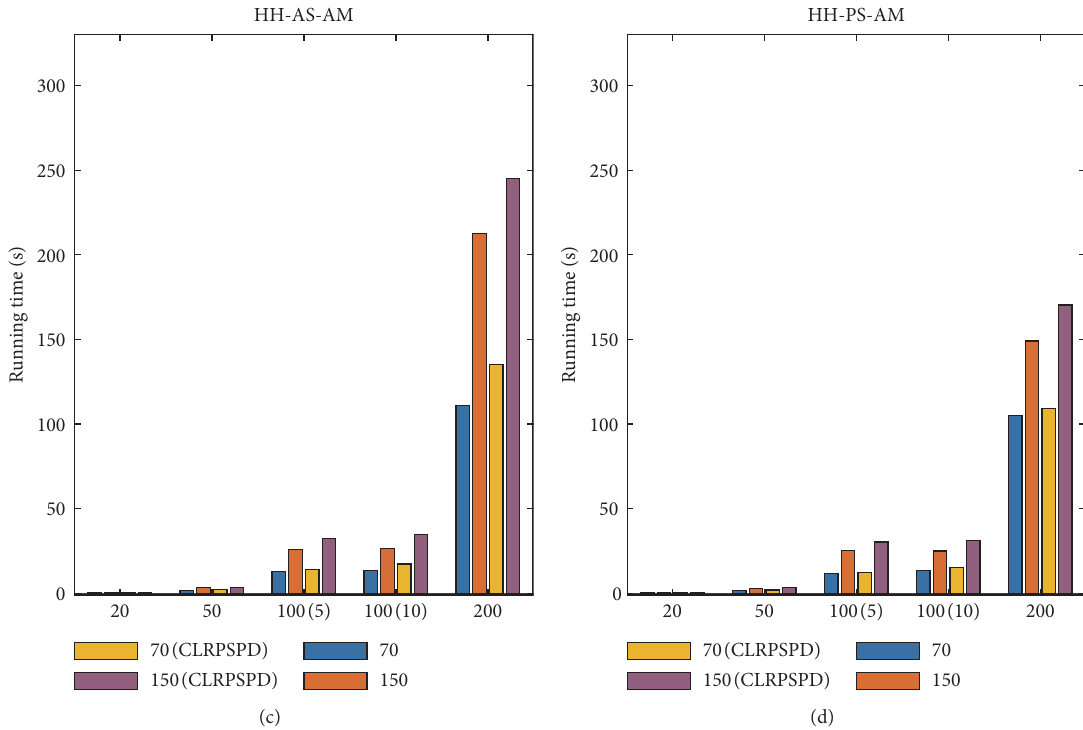
Figure 5: Histogram of computing times of different vehicle capacity.